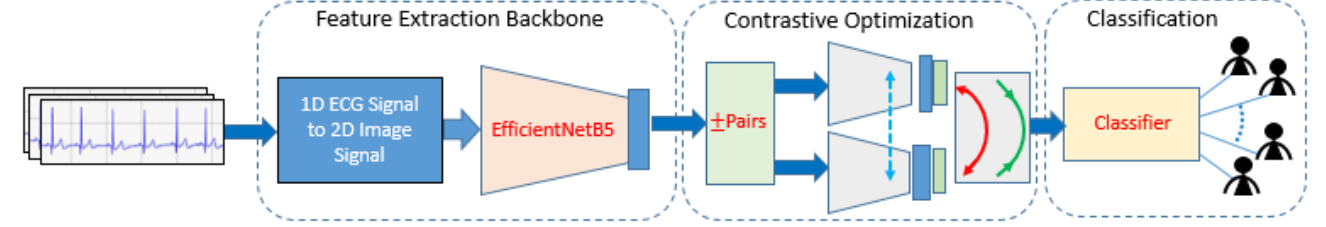
Figure 3. Flowchart of the proposed system. The input ECG signal is fed into the feature extraction block, then passed into the contrastive optimization block and, finally, the classification block confirms the identity of the subject.